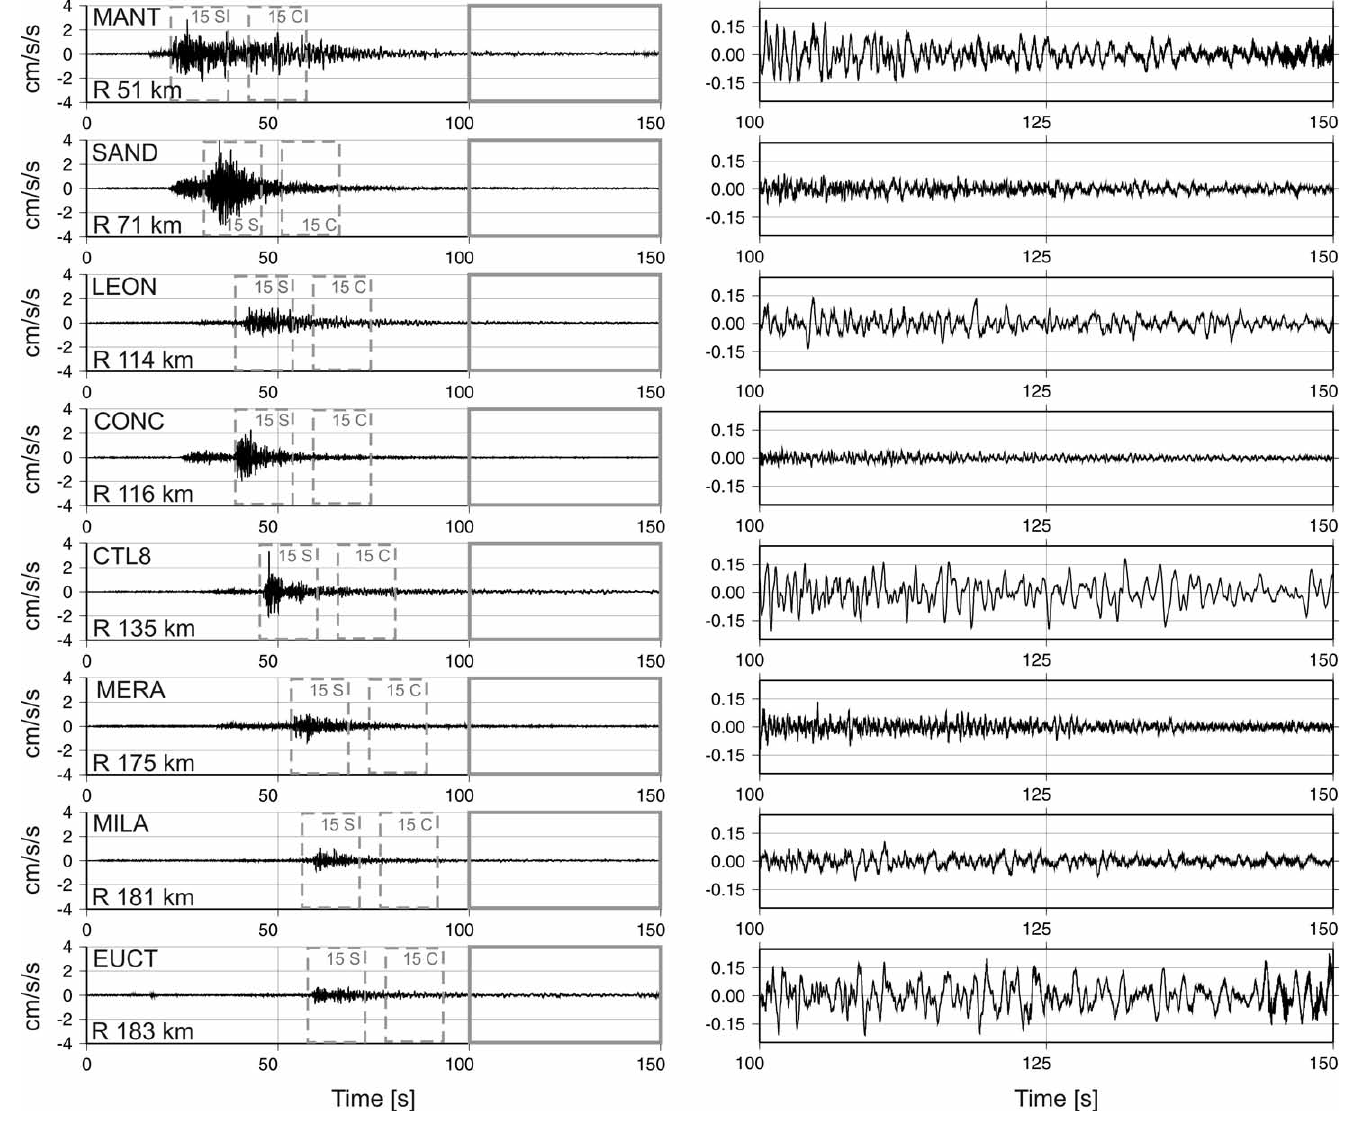
Figure 2 . Strong-motion recordings at the RAIS stations analyzed. Left: North-south components of the July 17, 2011, event. Recordings are shown in relation to their arrival times. Gray dashed insets, portions of the signals (15 s of S and coda phases) considered during the spectral analysis. Right: Particular of coda windows indicated by the gray solid inset in the left panels.